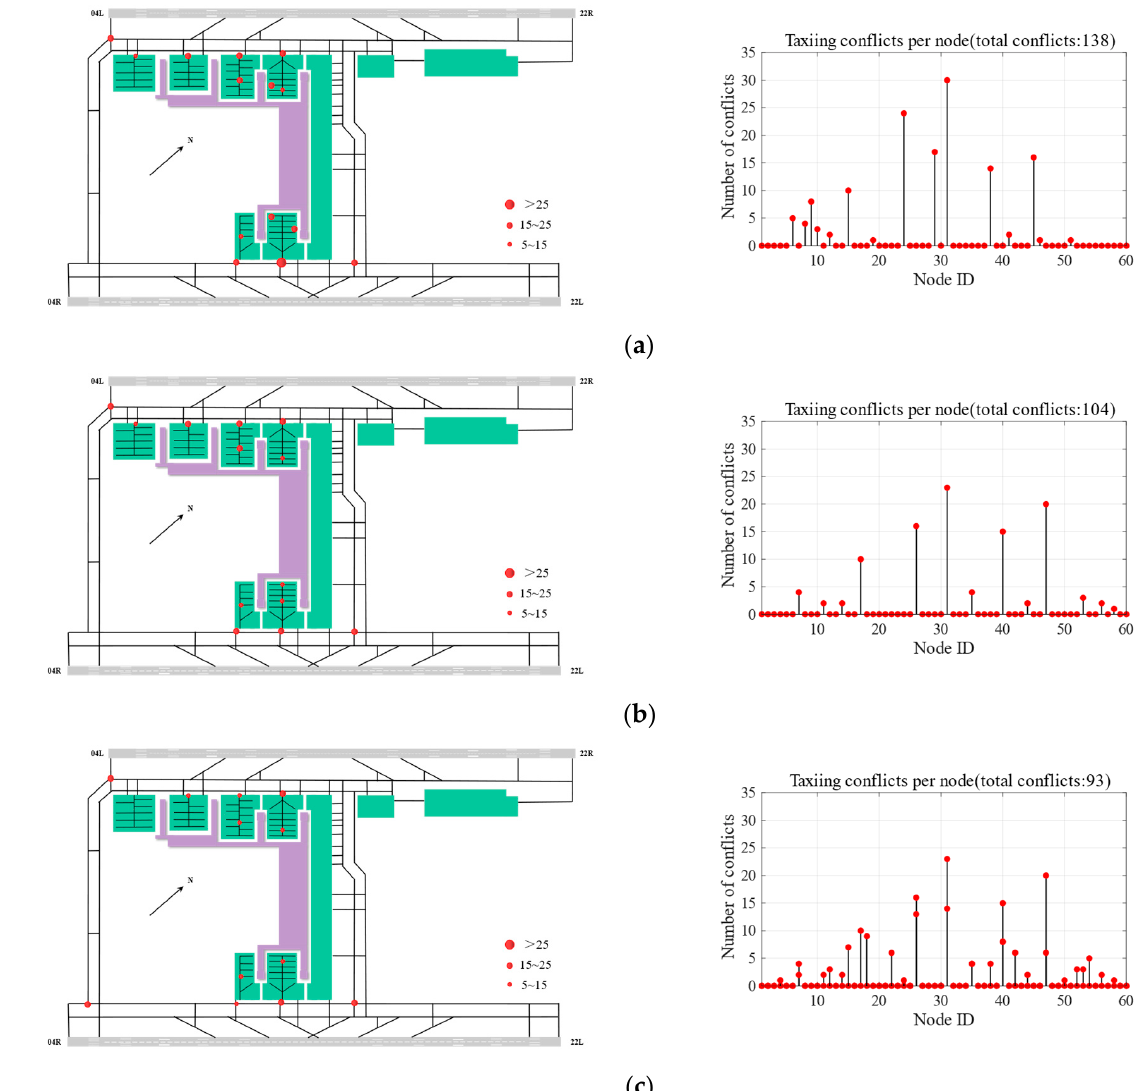
Figure 14. Number of Conflicts on the Surface Network under Three Apron Operation Procedures. ( a ) Exclusive; ( b ) Partition-shared; ( c ) Global-shared.